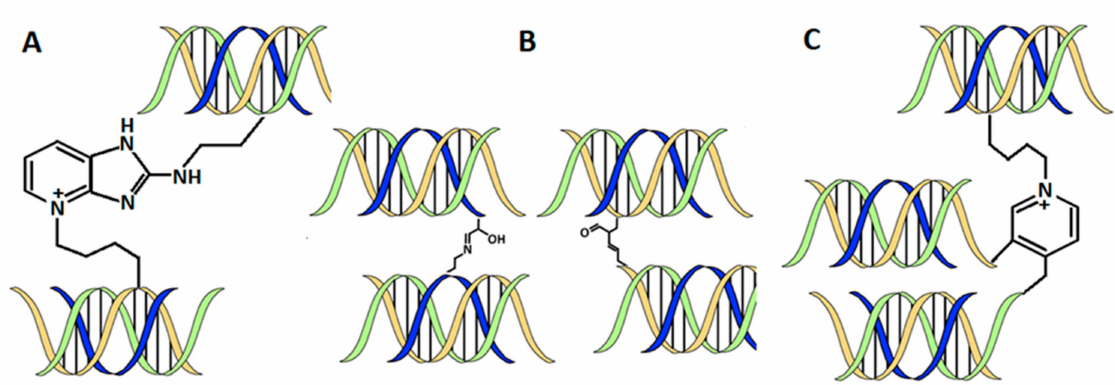
Figure 3. Collagen and its non-enzymatic ( A ) and enzymatic divalent ( B ) and trivalent ( C ) nature